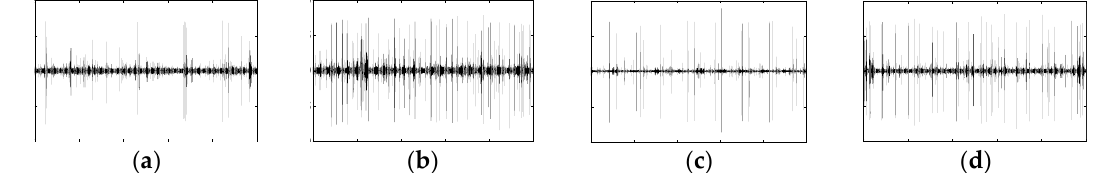
Figure 10. The examples of AE signals for each bearing conditions listed as: ( a ) the AE signal of the healthy bearing; ( b ) the AE signal of ORCS; ( c ) the AE signal of IRCS; and ( d ) the AE signal of RECS.